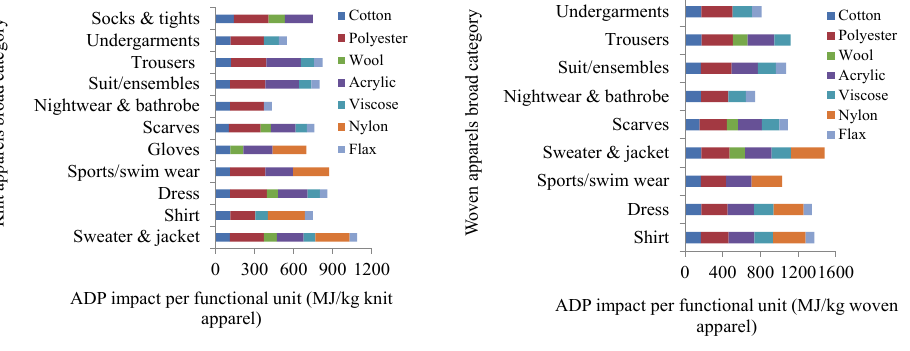
Fig. 7. ADP impact (per kilo-gram apparel) of knit and woven apparel broad categories.